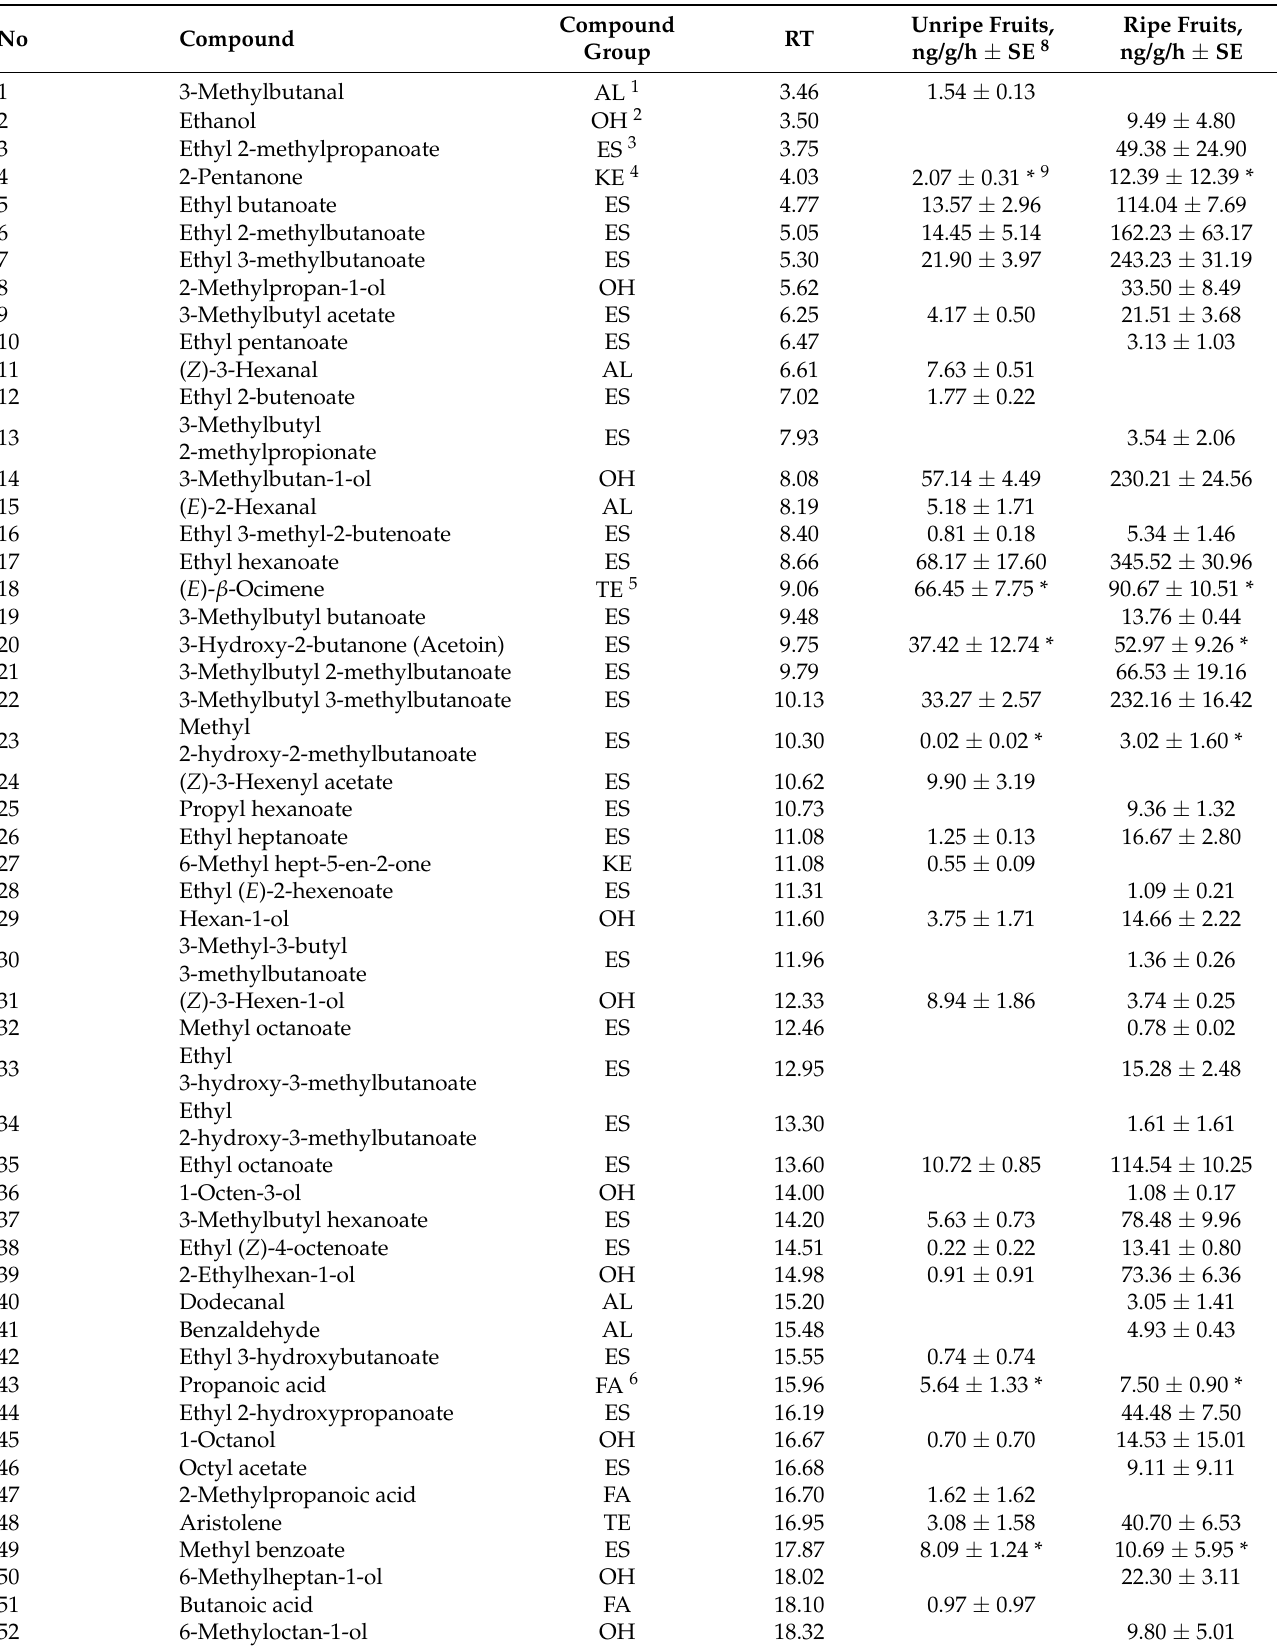
Table 1. Volatile compounds identified in the headspace of sea buckthorn Hippophae rhamnoides fruits at two ripening stages: unripe fruits and ripe